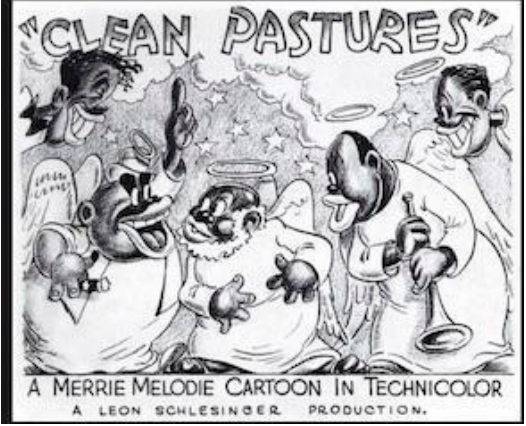
Figure 2. Black religion caricatures, Clean Pastures cartoon, 1937.